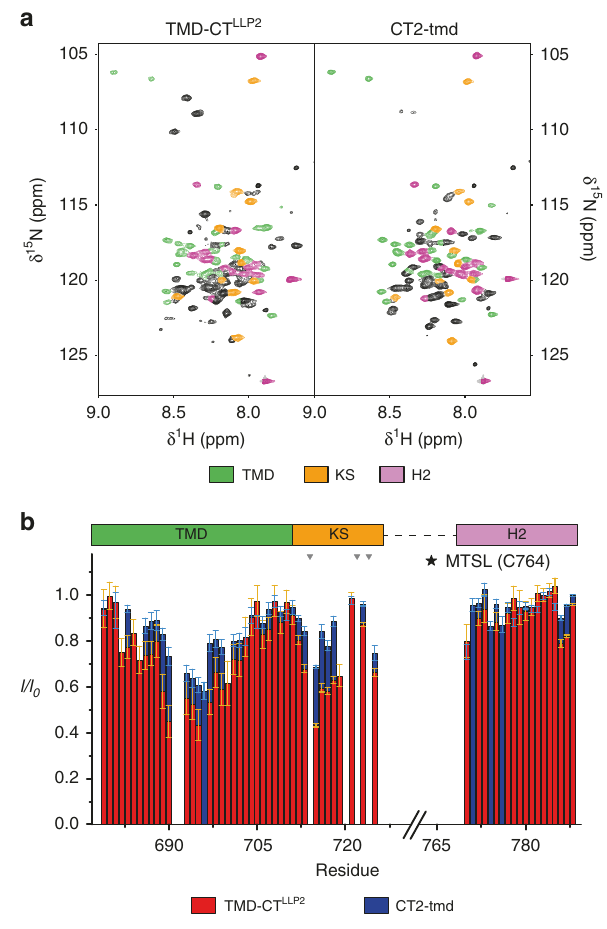
Fig. 3 Destabilization of the TMD – CT interactions loosens the CT baseplate. a Comparison of the 2D 1 H – 15 N TROSY-HSQC spectra of the TMD – CT LLP2 (left) and CT2-tmd (right), showing strong agreement among the two constructs of the chemical shift of residues 679 – 710 (TMD), 711 – 725 (KS), and 770 – 788 (H2) highlighted in green, orange, and pink, respectively. Bearing the mutation site, H1 exhibited strong chemical shift changes (black cross-peaks) and thus was not further analyzed. b Comparison of residue- speci fi c PRE ( I / I 0 ) of TMD – CT LLP2 (red) versus those of CT2-tmd (blue). readout) with unlabeled (and thus “ NMR-invisible ” ) protein carrying the MTSL spin-label at position S764C, following the strategy summarized in Fig. 2a (see the Methods section for details). Error bars represent the uncertainty derived from cross-peaks signal to noise. Missing bars are due to prolines (indicated by gray triangles) or overlapping residues. The position of the paramagnetic tag is marked by a star. Source data are provided as a Source data fi clade A isolate 92UG037.8, and we further characterized 11 of